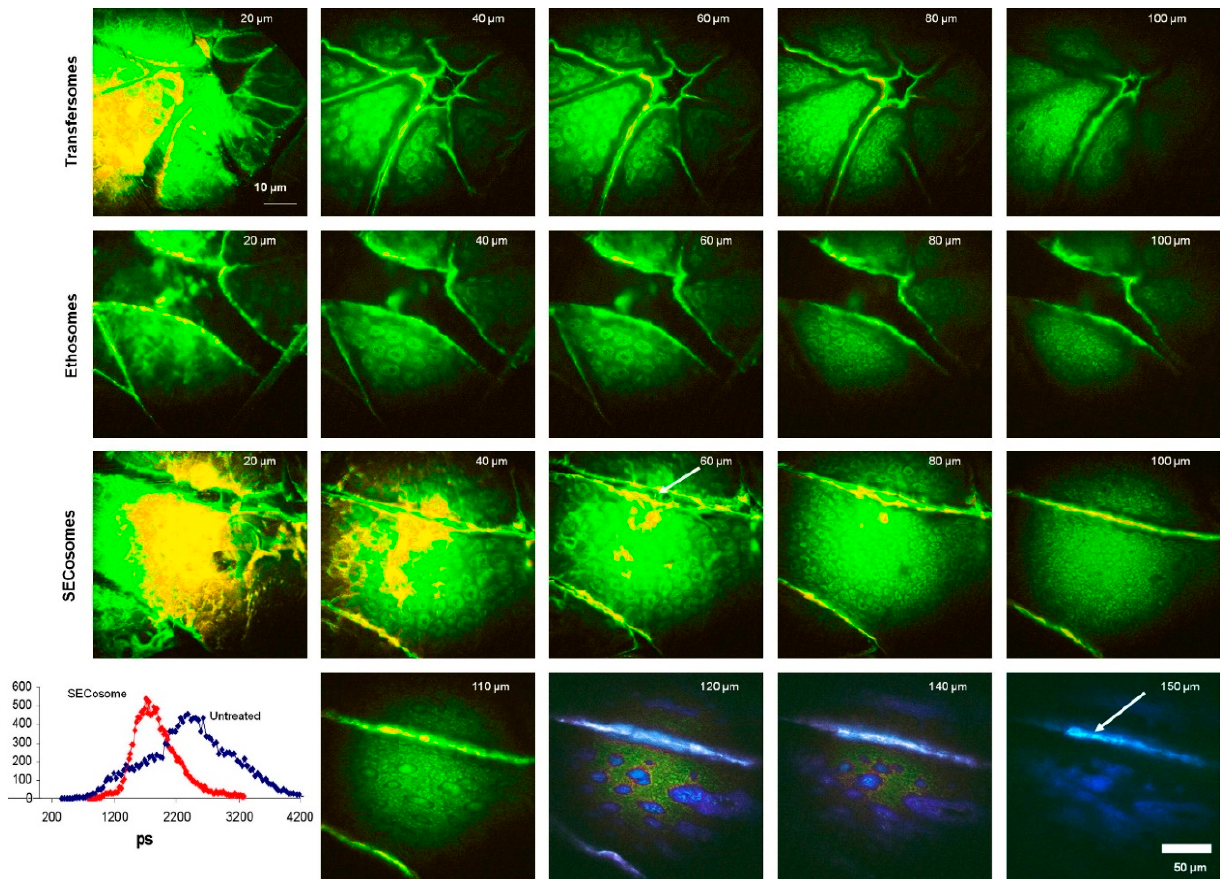
Figure 6 . Penetration of 5-carboxyfluorescein-labeled siRNAs into flexible liposomes from freshly excised human skin. The sizes of the liposomes and the percent size decrease caused by filtration through a 30 nm porous filter were as follows: transferosomes 98 nm (30%); ethosomes 79 nm (11%); 58 nm secosomes (3%) and 98 nm rigid liposomes, (-). Reproduced without modification and with permission from [245].